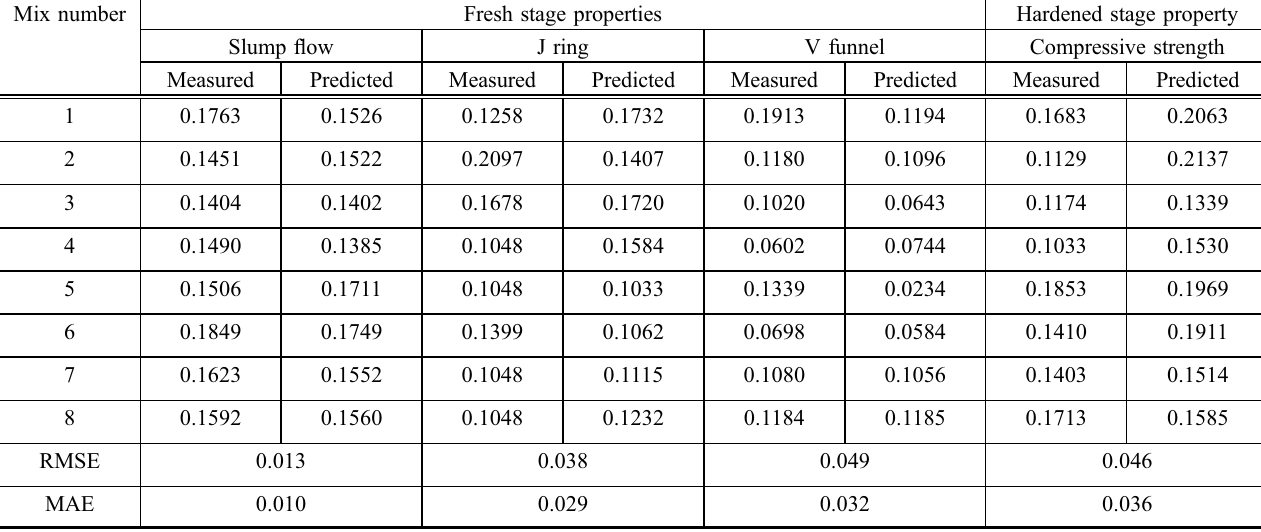
Table 6 Comparison of measured and predicted normalized values of unfamiliar